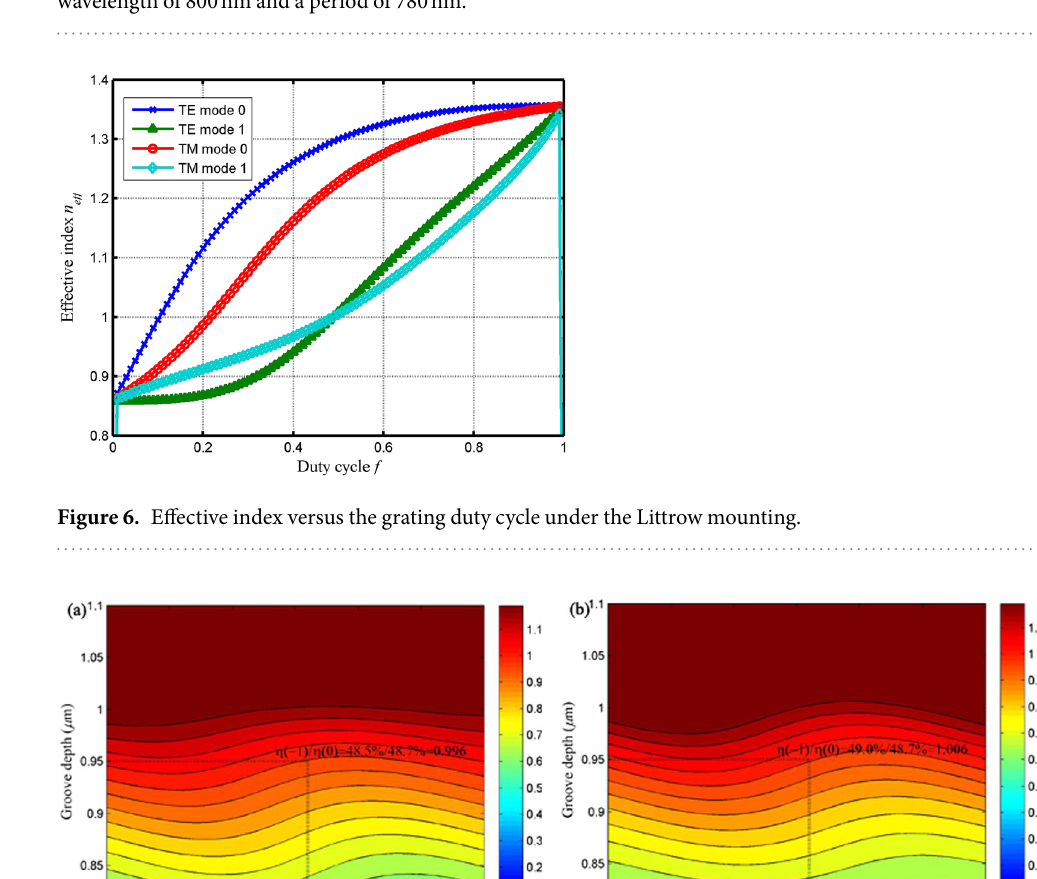
Figure 5. The phase difference ratio between Δϕ TE and Δϕ TM versus the grating duty cycle at an incident wavelength of 800 nm and a period of 780 nm.